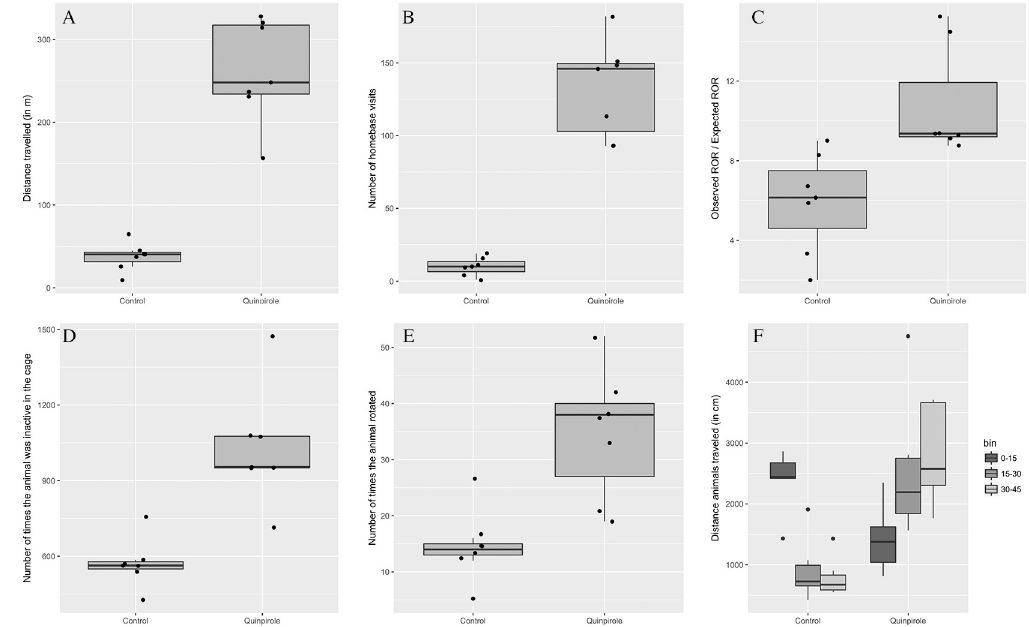
Fig 2. Behavioural data. The mean travelled distance (A) as well as the number of HB visits (B) are plotted here for the quinpirole (QP) condition and the control (CTRL) condition. Also, the ratio of observed to expected HB stops (C) is shown for both the chronic QP group and the chronic CTRL group. Additionally the total frequency of inactivity as a measurement for freezing behaviour (D) is and the total amount of rotations (E) that animals performed after receiving either quinpirole or saline are displayed. Finally, the activity of the animals is displayed with the total duration spent in the cage split into different time bins of each 15 minutes (F). Individual points, median and standard deviation of the group are displayed.